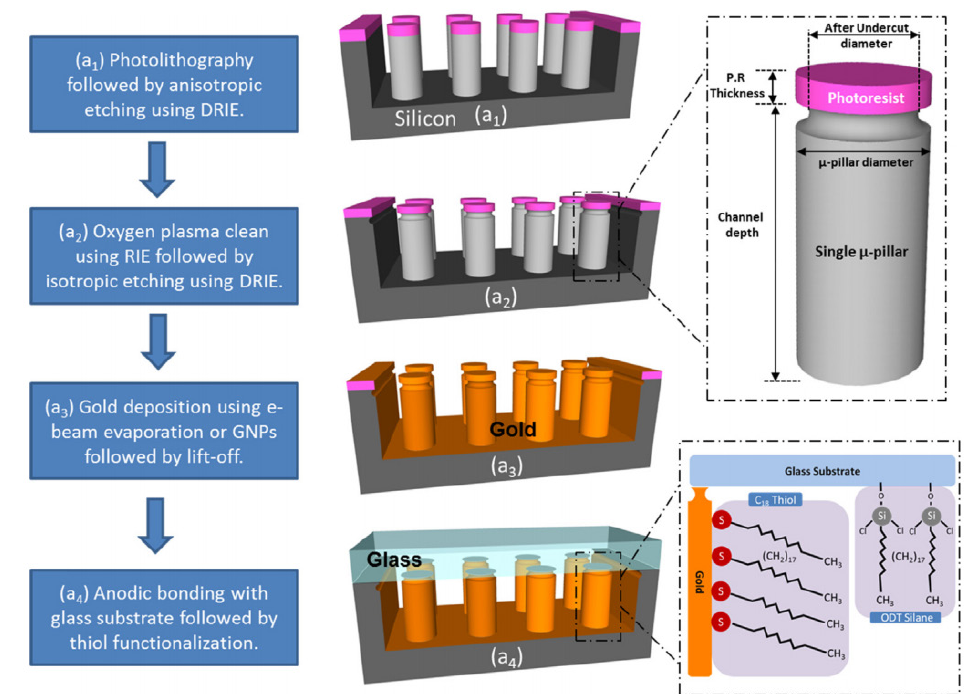
Figure 6: Schematic diagram of MEMs column and Alkane thiol functionalized thin gold